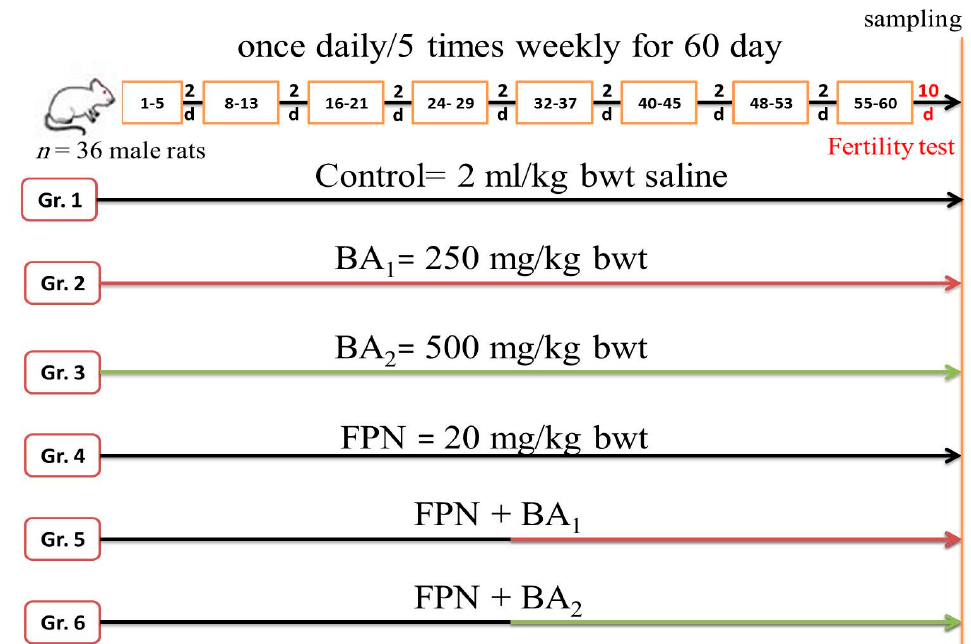
Figure 1. The experimental design. FBN, Fipronil. BA1, Boswellic Acid 250 mg/ kg bwt. BA2, Boswellic Acid 500 mg/ kg bwt. Gr, Group